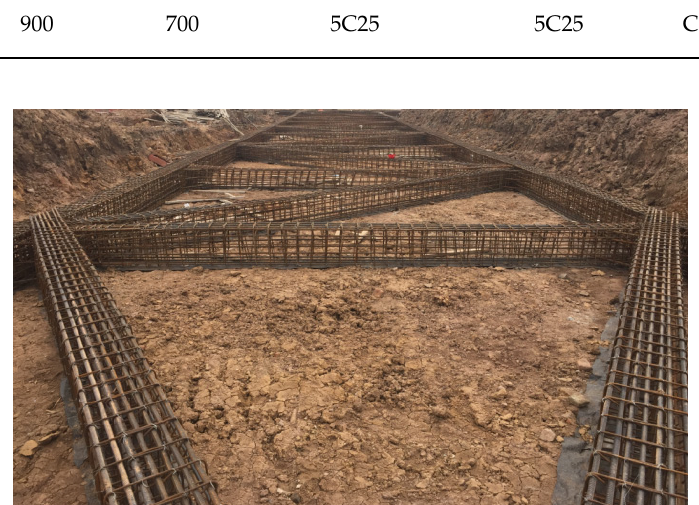
Figure 3. Steel bar binding of the inner brace.